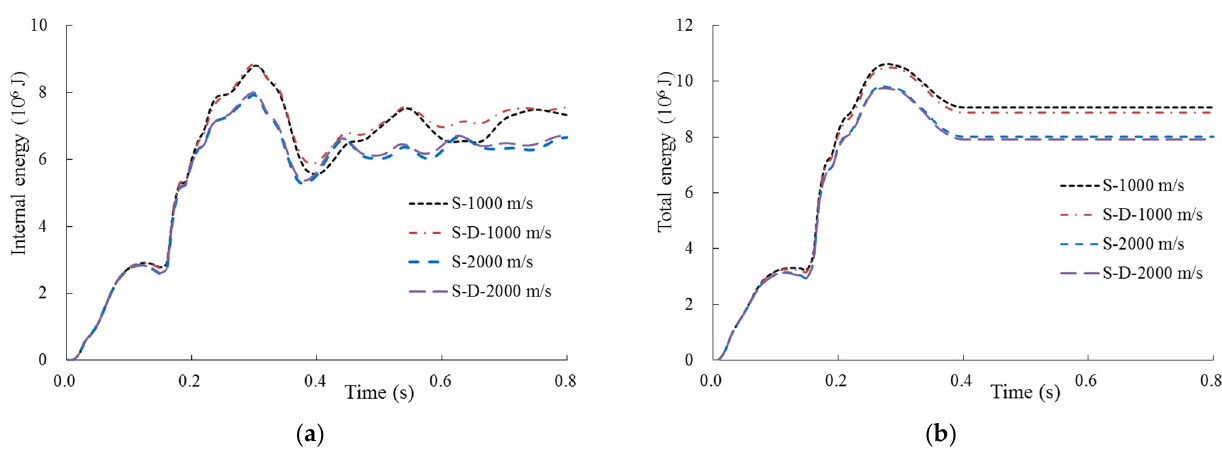
Figure 22. The internal energy and total energy of containment for the sites of Vs = 1000 and 2000 m/s. ( a ) Internal energy. ( b ) Total energy.